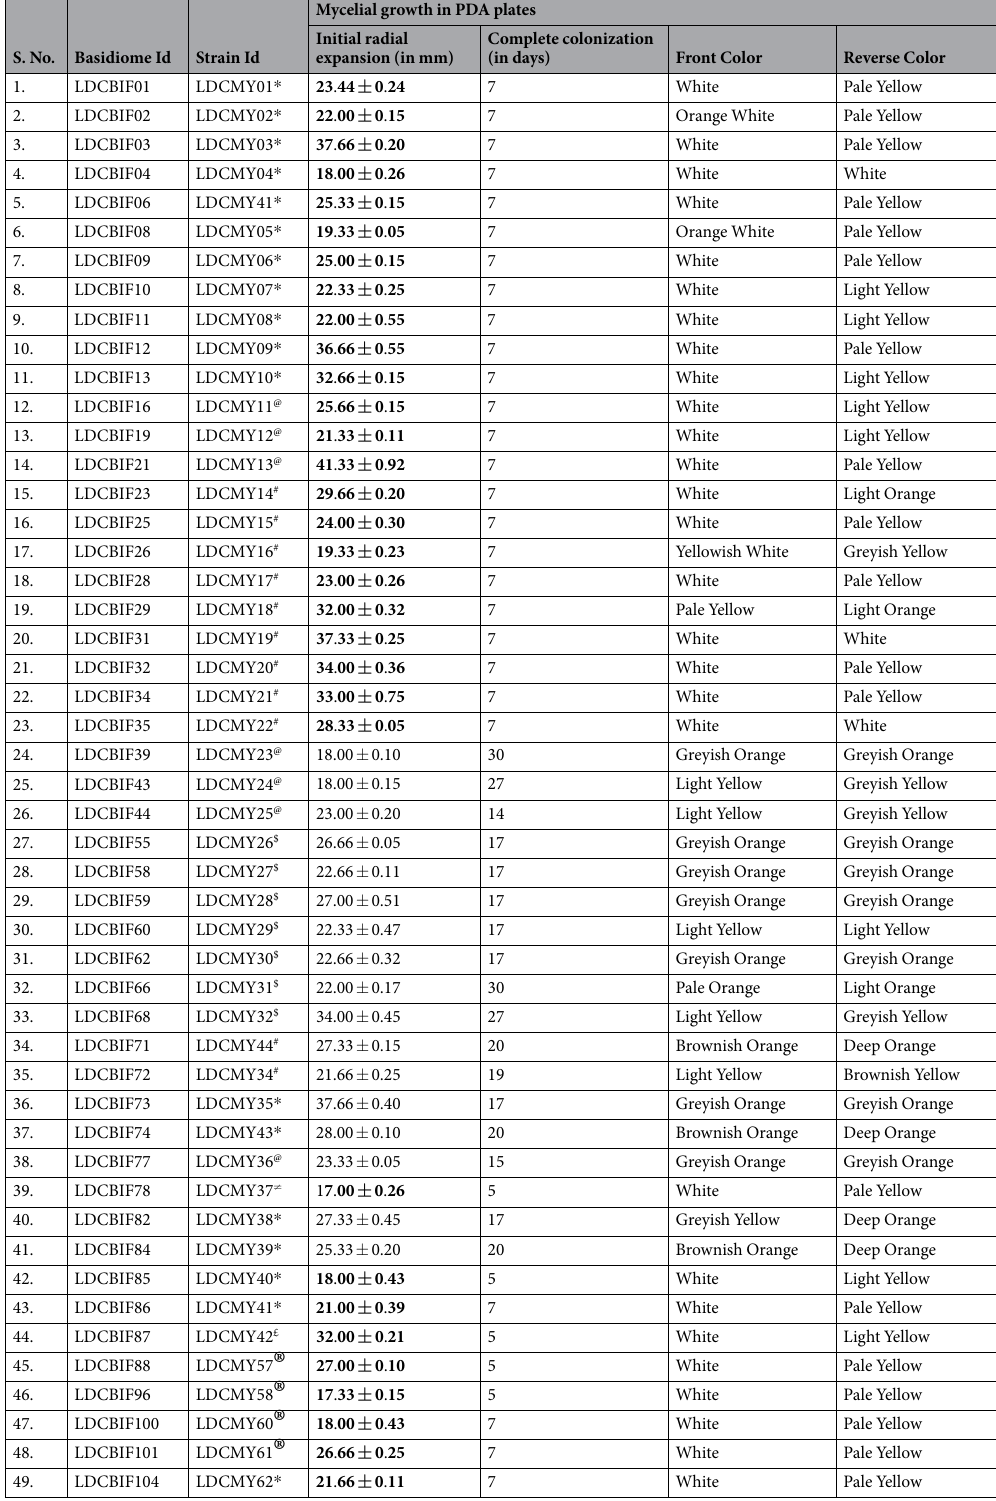
Table 2. Growth and characteristics of mycelium culture. $ ,€, * , # , ≠ , @ , ® U sed to denote the strains collected from different places. $ Ayyanar falls; € Coimbatore; * Lady Doak College Campus; # Nagamalai; ≠ Thenkasi; @ Pudhupatti; ® Tirunelveli. The radial expansion was measured on the 3 rd day (shown in bold) and 7 th day. The measurements are given in mean ± SD. The total number of days taken for complete colonization (80 mm) in PDA medium varied among the isolates and ranged from 5–30 days for different